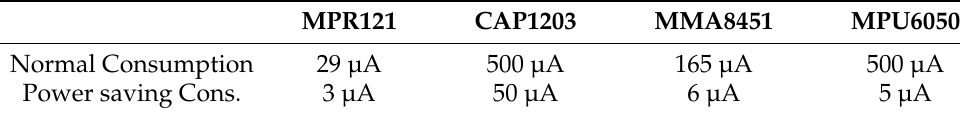
Table 2. Capacitive and accelerometer sensors analysis.